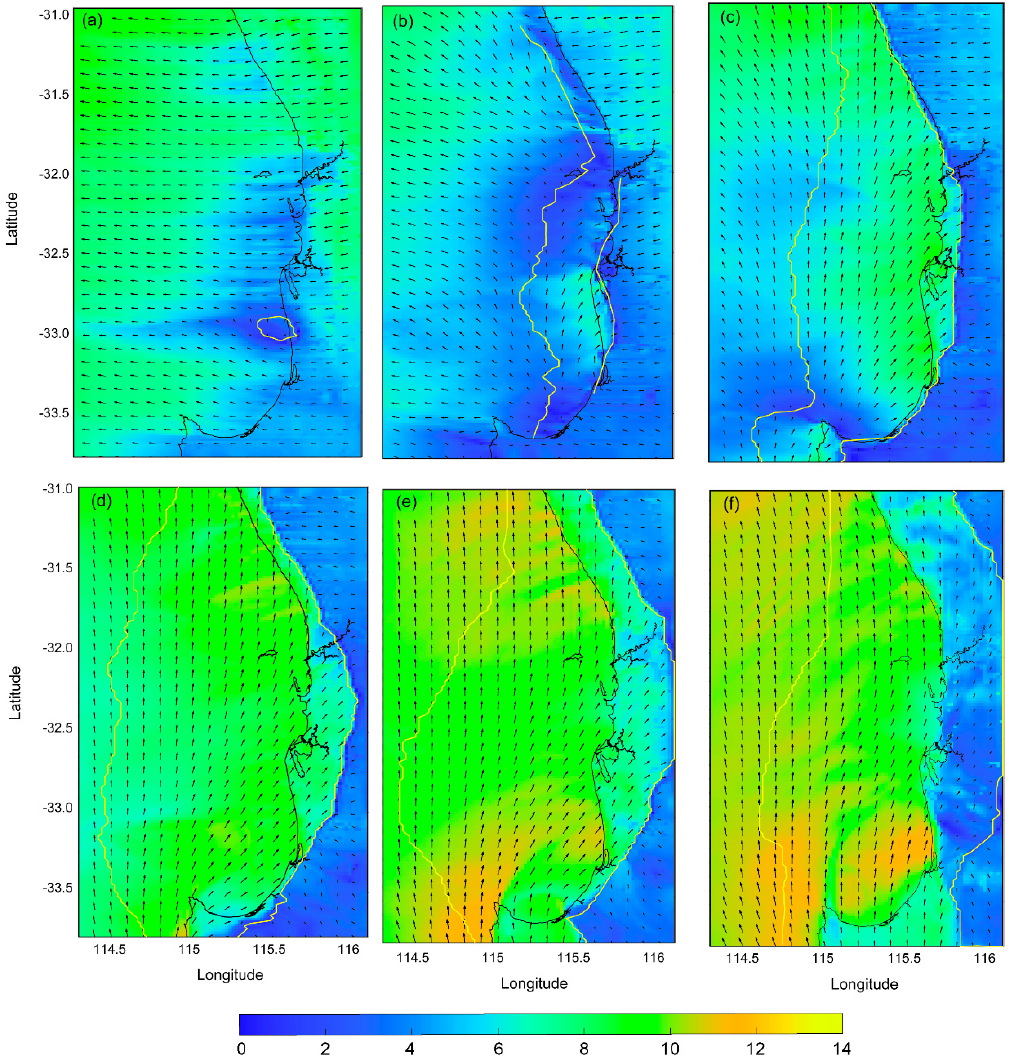
Figure 8. Time series (two-hourly intervals) of the spatial distribution wind vectors for south-west Australia during a typical sea breeze cycle predicted from the WRF model on 8 December 2016. ( a ) 0800; ( b ) 1000; ( c ) 1200; ( d ) 1400; ( e ) 1600; and ( f ) 1800. The contour outline of the sea breeze cell is shown by the yellow line. The colours represent wind speed in ms − 1 .